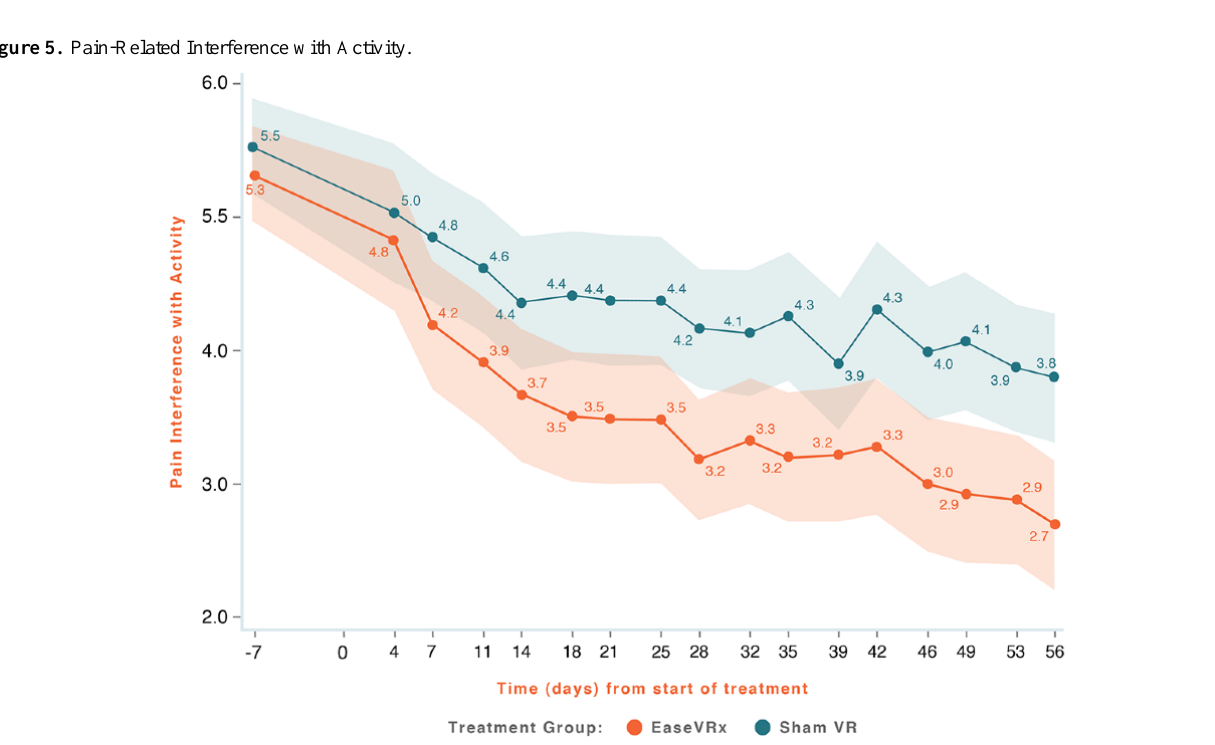
Figure 5. Pain-Related Interference with